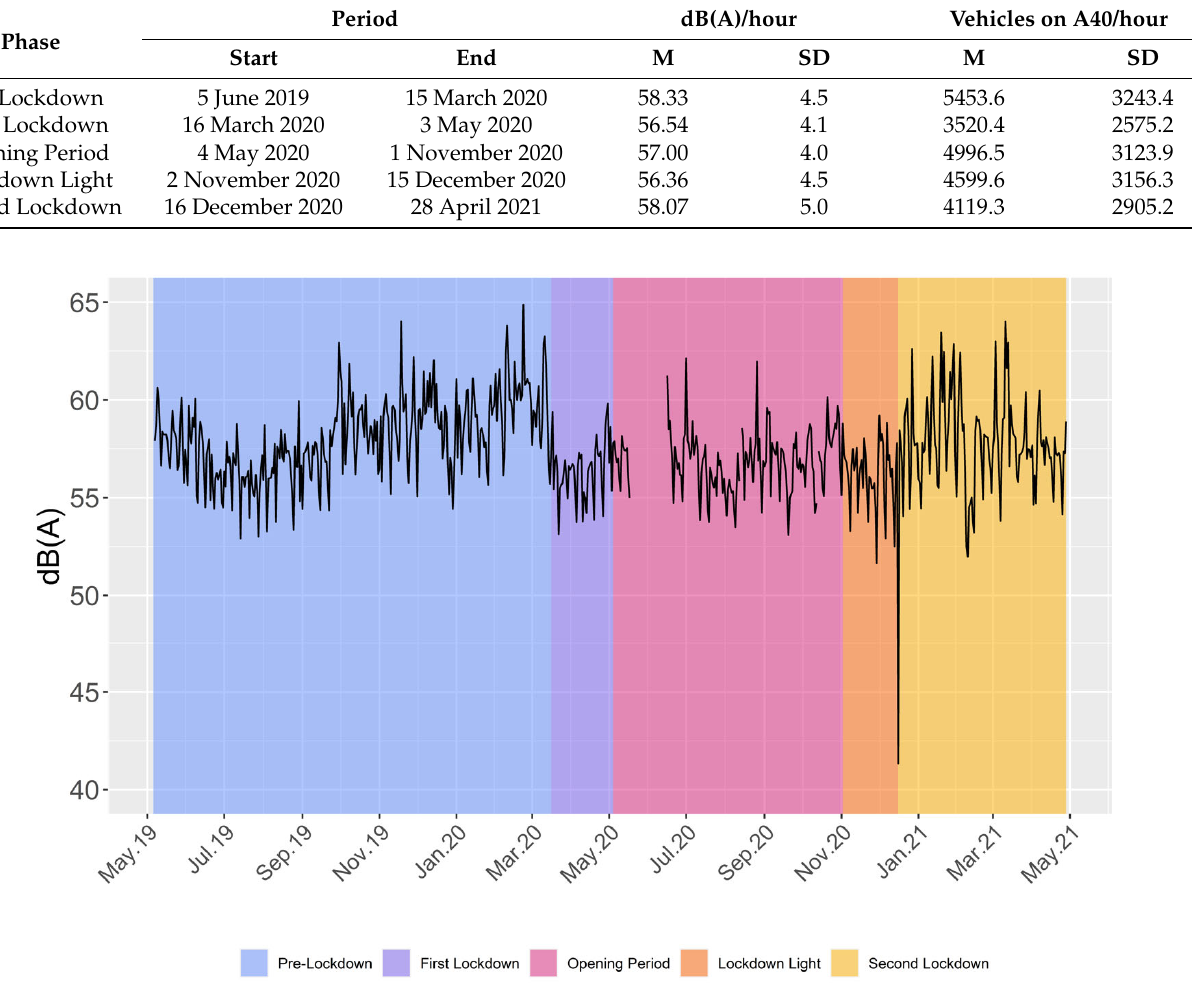
Table 1. Mean values (M) and standard deviations (SD) of dB(A) and vehicles on A40 per hour for all devices are depicted over the four different lockdown phases and the pre-lockdown phase.